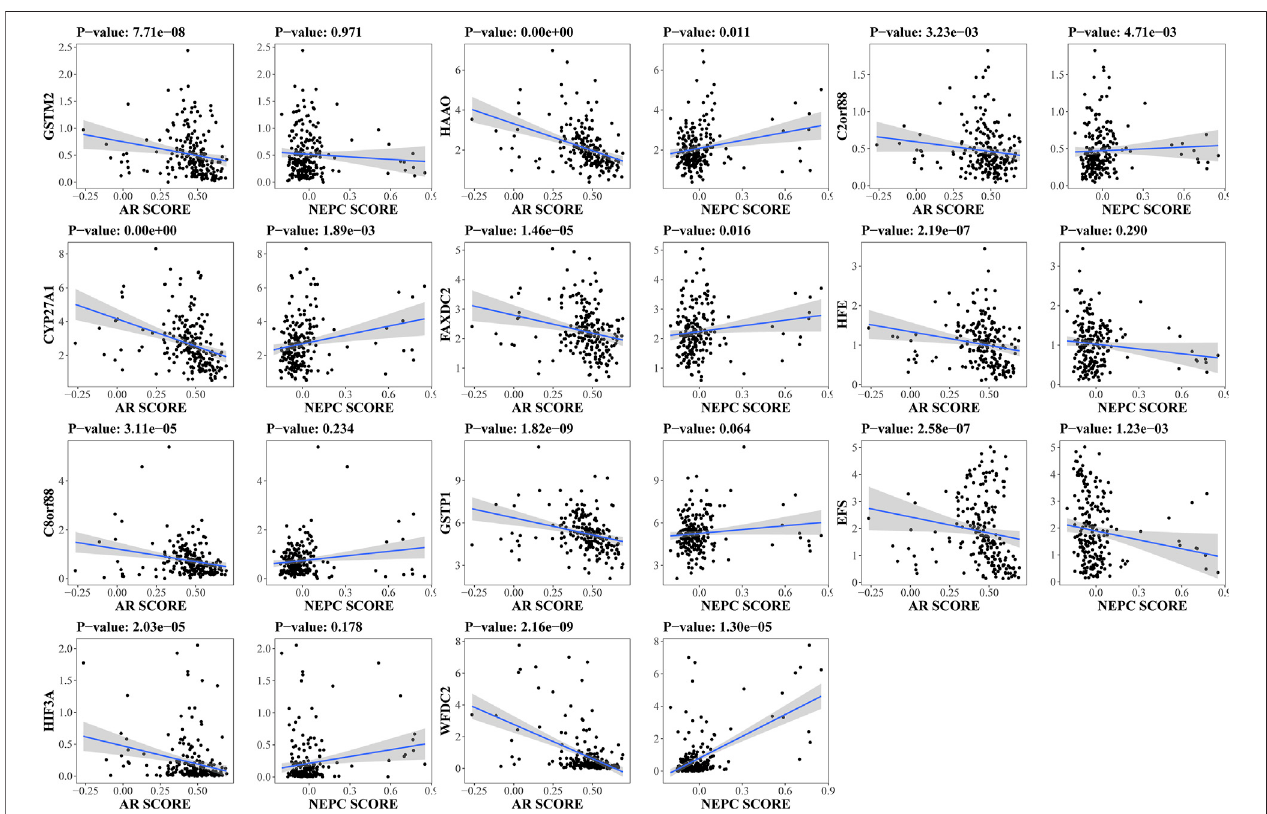
FIGURE 9 | Exploration of correlation between expression levels of driver genes and unique characteristics of PCa. Spearman correlation analysis was conducted in SU2C dataset to disclose their associations. AR score: Androgen receptor score; NEPC score: Neuroendocrine prostate cancer score.